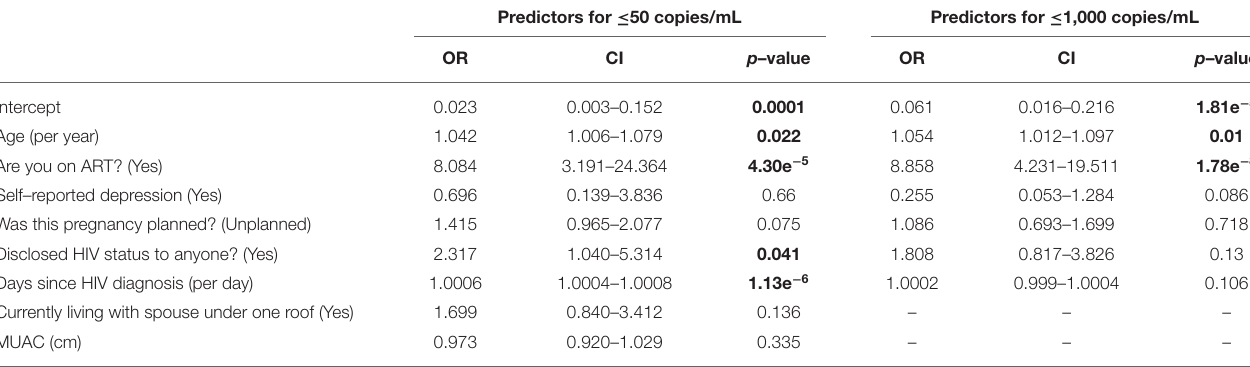
TABLE 4 | Predictors of virological outcomes for all women (naïve + on ART) with variable elimination.